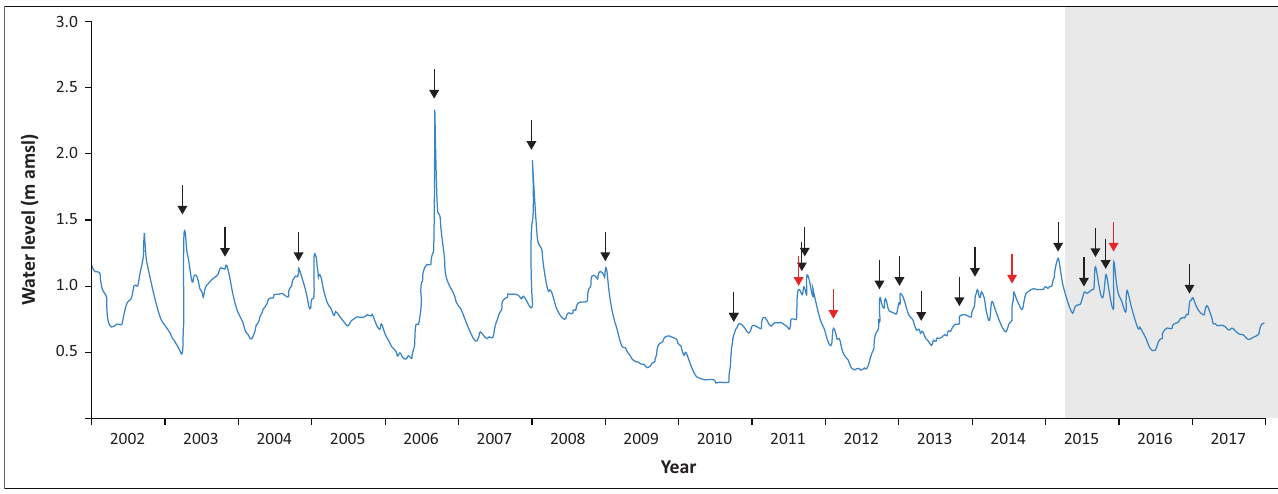
FIGURE 3: Water level relative to sea level in Rondevlei from 2002 to 2017. Arrows indicate times of breaching of the Touw Estuary mouth (black = artificial breaching, red = natural breaching). Shaded area indicates the period when botulism-related deaths of waterbirds were recorded in the Wilderness Lakes.